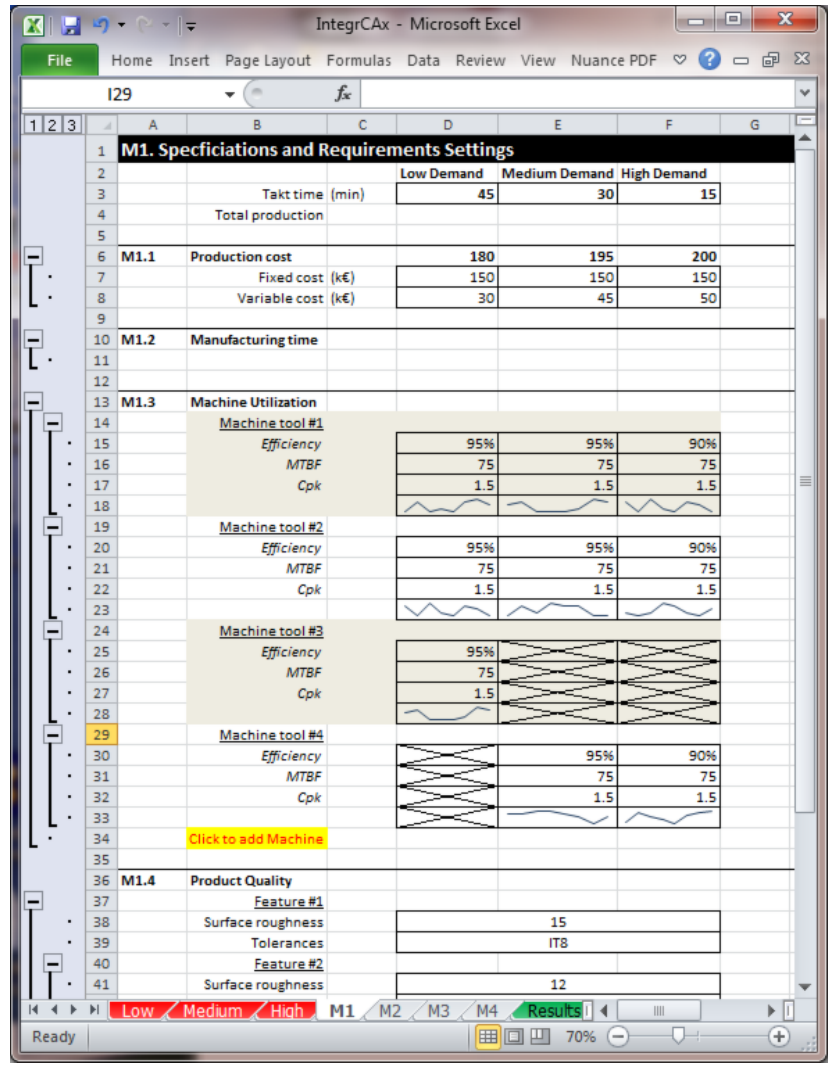
Figure 9. Sustainability assessment tool screenshot. Energies 2020 , 13 , x FOR PEER REVIEW